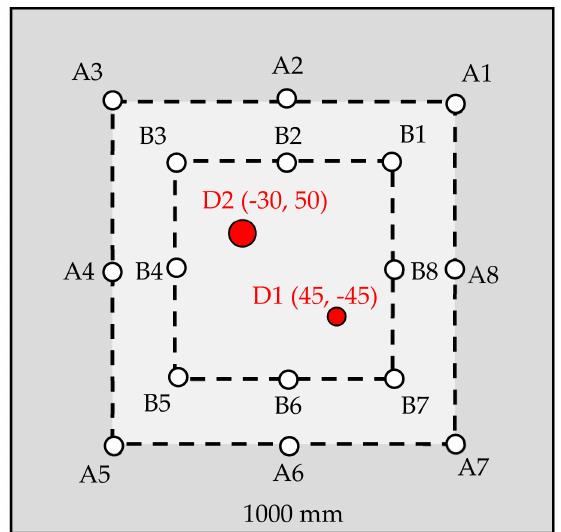
Figure 16. Multiple damage